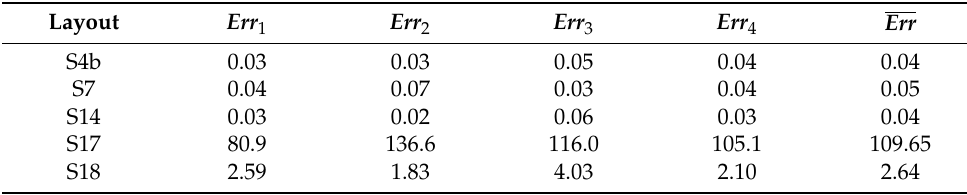
Table 2. Normalized errors on control sensors for each reconstruction